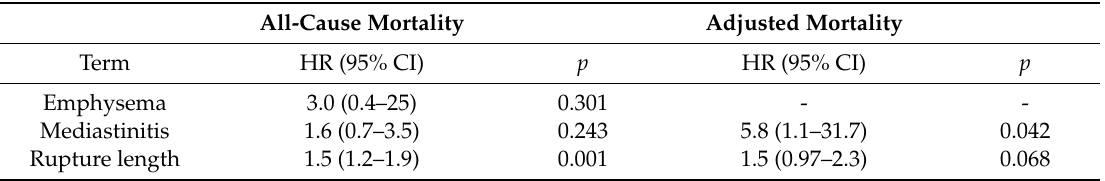
Table 4. Multivariate analysis for survival of iatrogenic tracheal rupture.